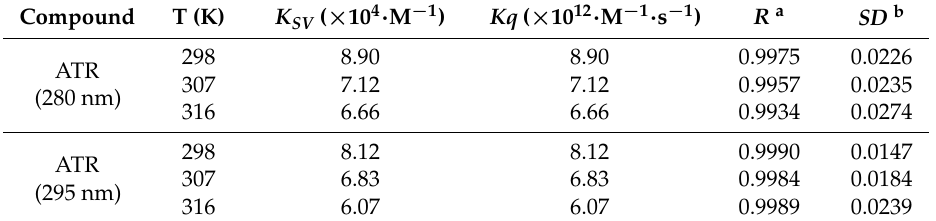
Table 1. Stern-Volmer quenching constants for the interactions of ATR with HSA at different temperatures.